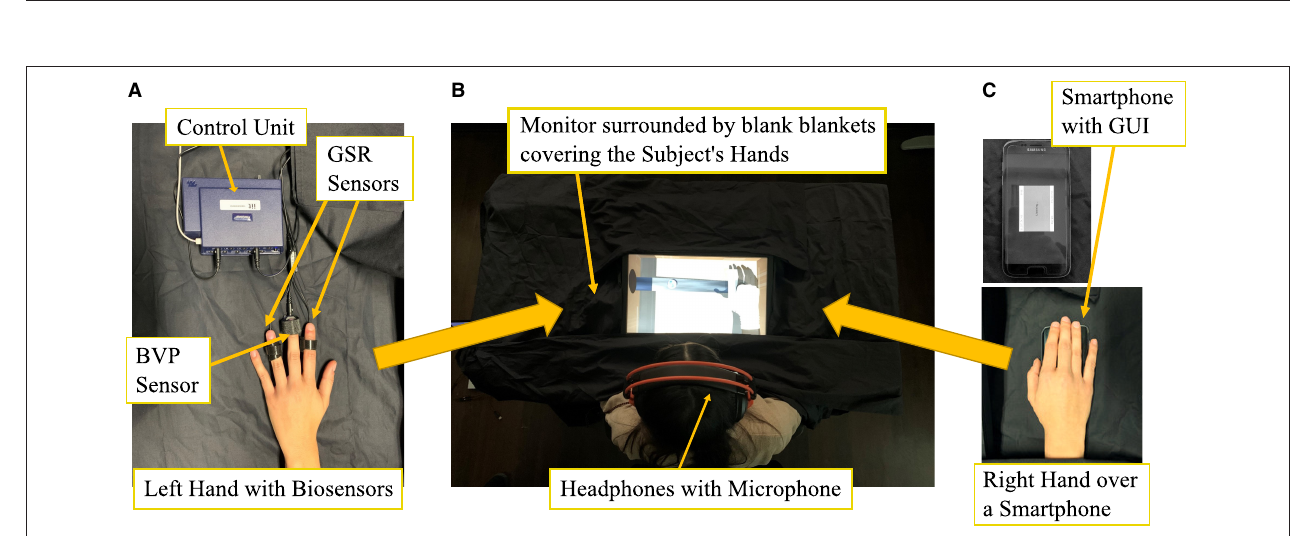
FIGURE 1 | Experimental setting with (A) participant and (B) scene on the display.